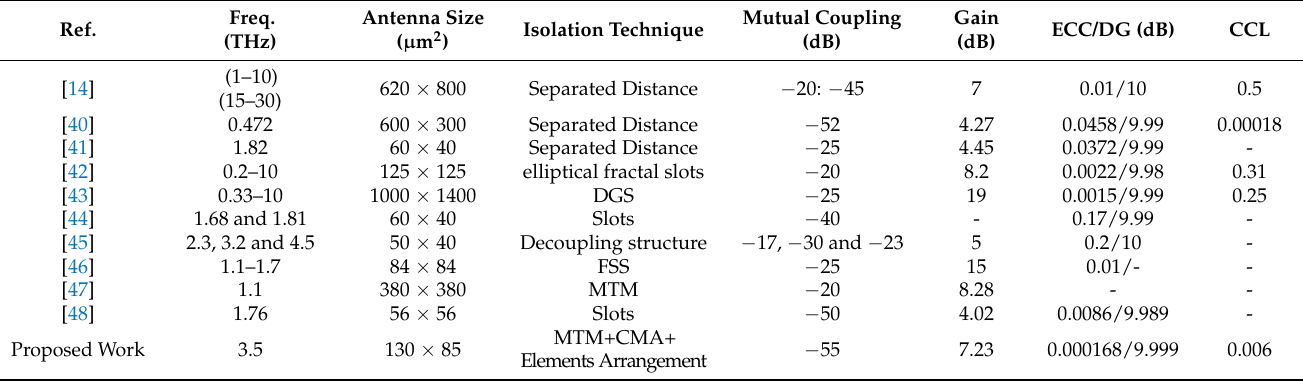
Table 2. Comparison of the proposed antenna performance with the state-of-the-art